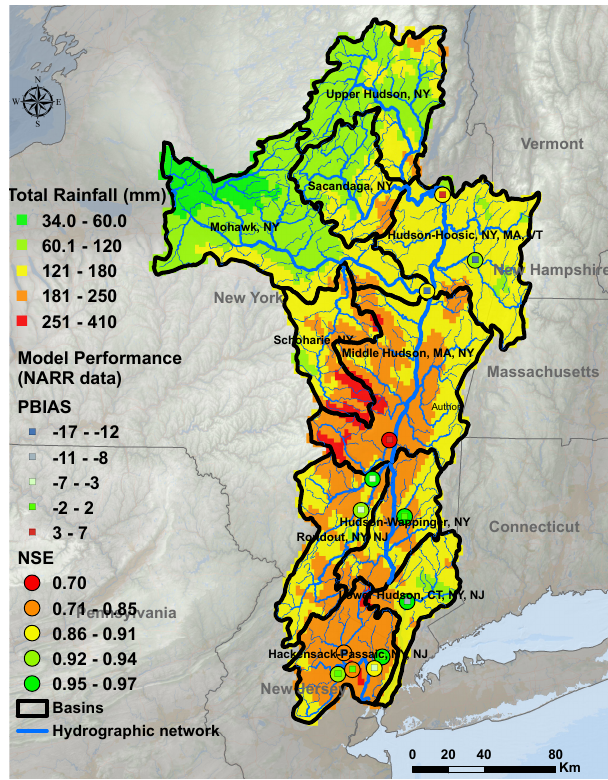
Figure 4. Summary of HEC-HMS performances at the USGS streamflow stations. The circles represent the criteria of Nash and Sutcliffe (NSE) while the squares represent the BIAS (%). The sta- tistical criteria are computed at hourly time steps. The model perfor- mances are illustrated for the NARR precipitation forcing. The map also shows the total observed accumulated precipitation received in 48h during 28–29 August 2011 (data from National Oceanic and Atmospheric Administration, 2011). The time series for selected flow stations are presented in Fig.